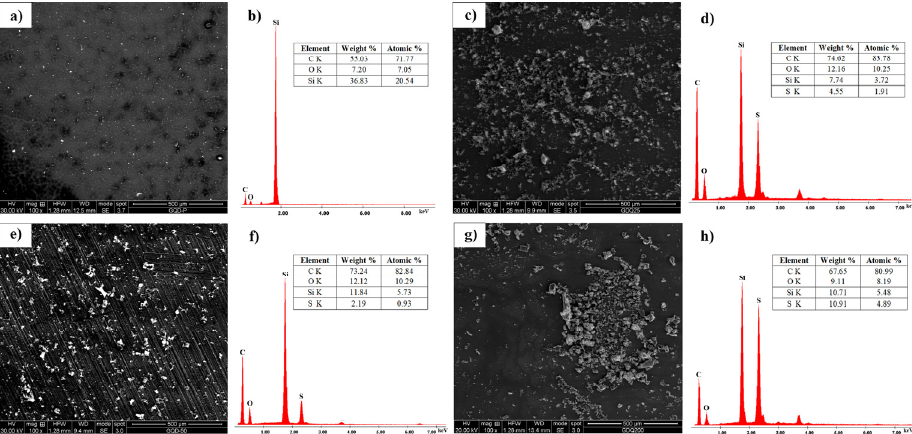
Figure 5. SEM images and EDS spectra of p-GQDs ( a , b ), GQD-cys-25 ( c , d ); GQD-cys-50 ( e , f ) and GQD-cys-200 ( g , h ).